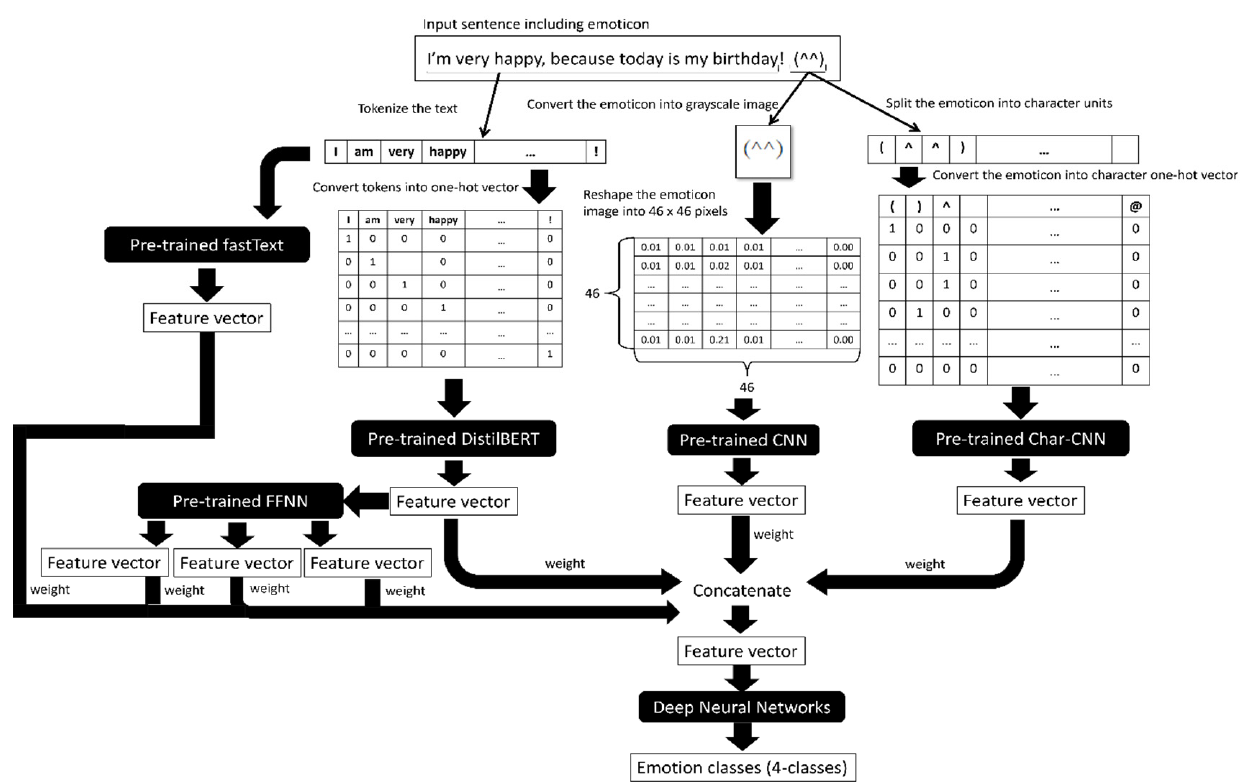
Figure 1. Overview of the proposed method.